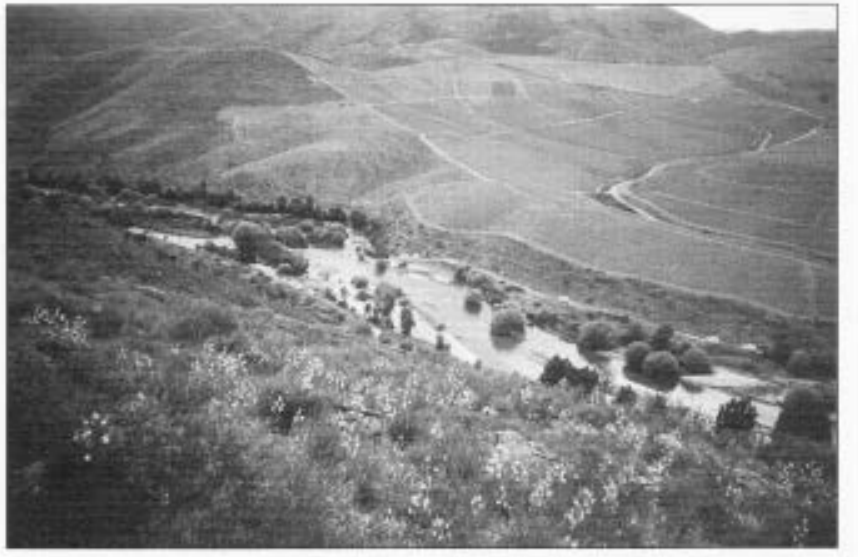
Figure 6 Laetoli: visit of Masai elders to the reburied trackway, 1 995. many of the engravings by the identifica­ tion and selective testing of Palaeolithic open sites in the same valley. This goal was achieved, and research has since concen­ trated on detailed recording of the rock art. Given that most of the panels of schist rock on which the engravings are made have been exposed since the Upper Palaeo­ lithic, any risks to their long-term preser­ vation were more likely to stem from the impact of visitors than from exposure to the